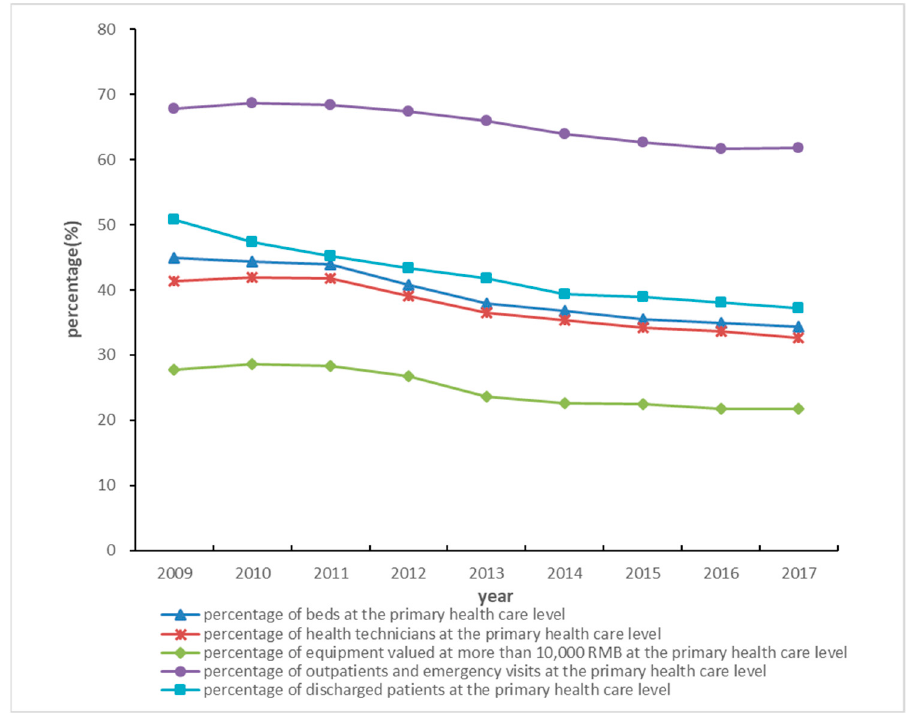
Figure 1. The percentage of inputs and outputs of primary health care institutions in 86 counties in Hunan Province from 2009 to 2017. Note: Percentage = sum of input (output) of primary health care institutions in 86 counties/sum of input (output) of medical institutions in 86 counties